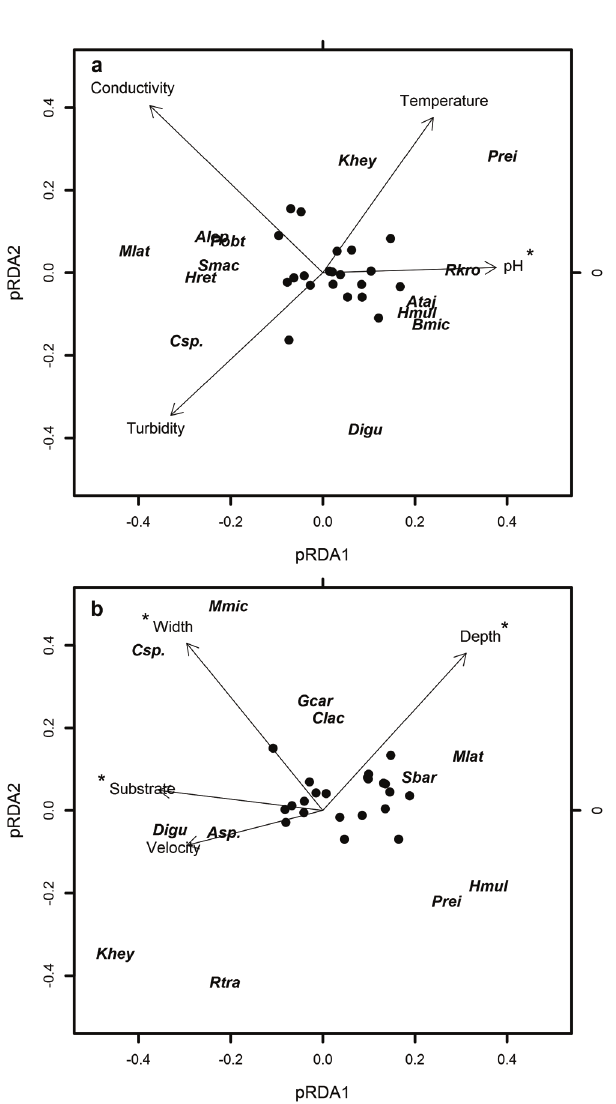
Fig. 3. Results of partial Redundant Analyses (pRDA) showing the patterns of correlation among species abundance with the pure limnological (a), and pure structural (b) predictors. The asterisks indicate environmental variables which were statistically correlated (p ≤ 0.05) with community composition. Only species with eigenvectors higher than 0.2 were identified by their abbreviated symbols. The others were identified by black dots. This limit was arbitrary but chosen to evidence only the species which were mostly correlated with environmental predictors.